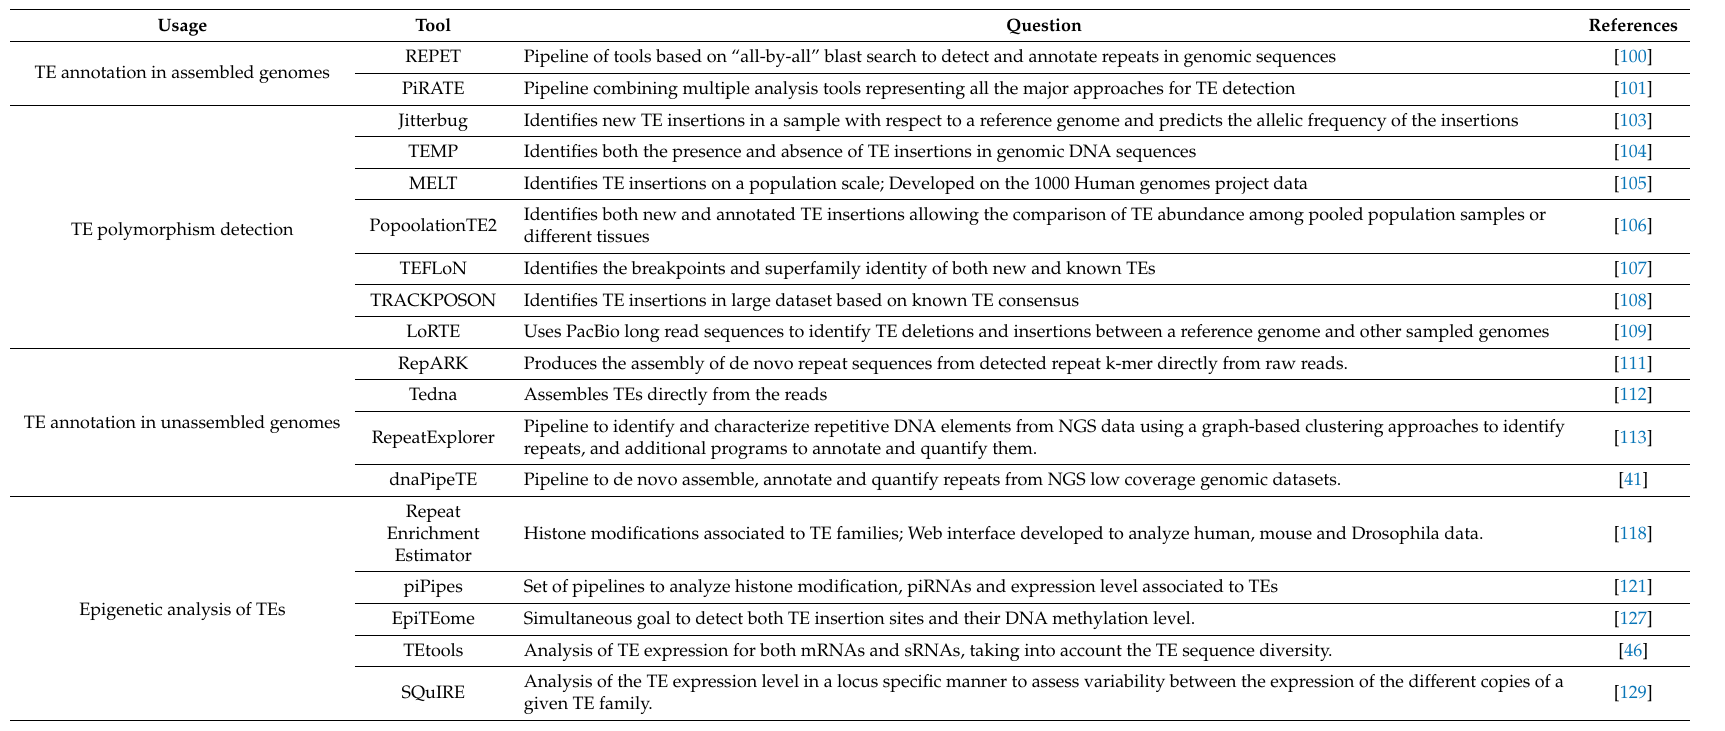
Table 1. Bioinformatic tools allowing the identification and analysis of